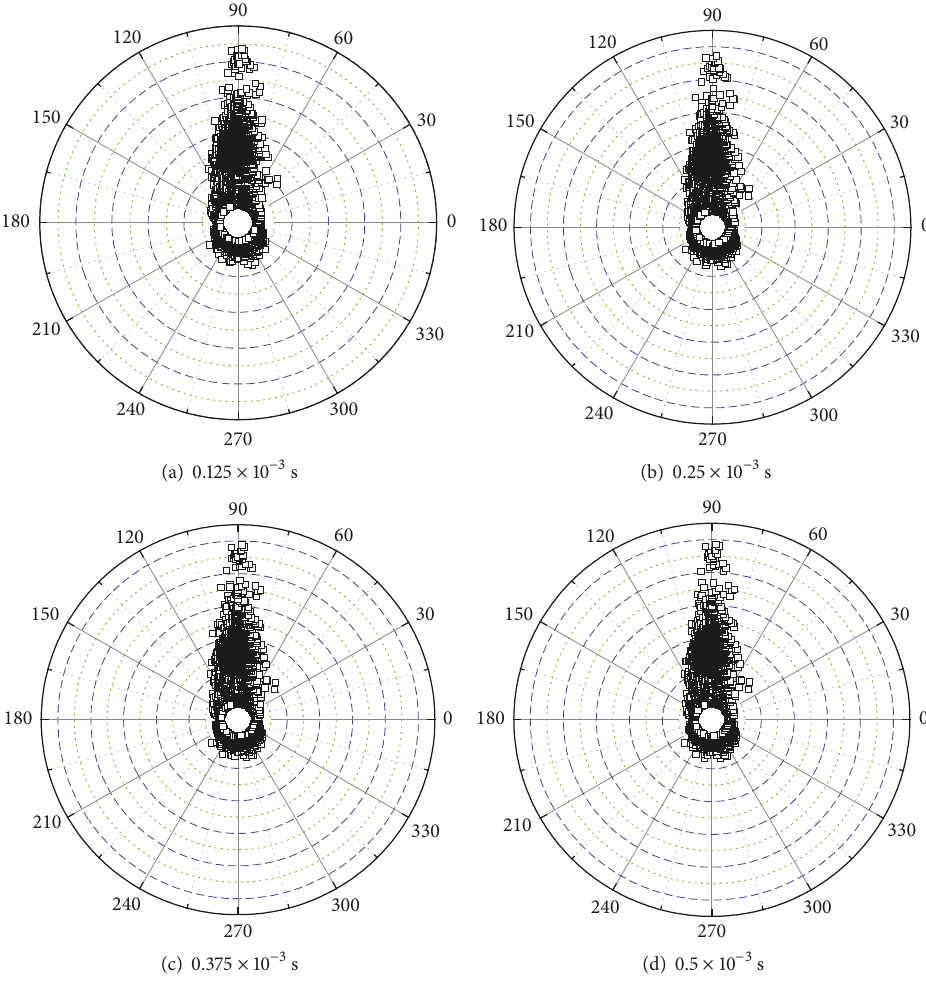
Figure 5: Angle distribution of force